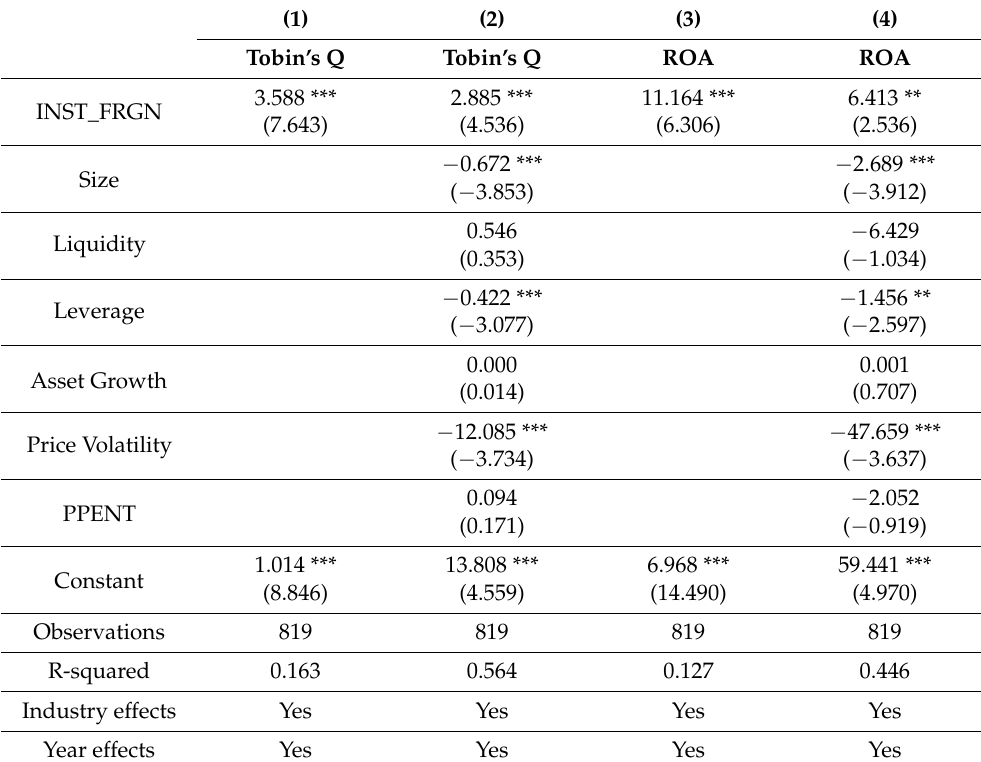
Table 5. Impact of Foreign Ownership on Firm Performance. results of Equation (1) using OLS estimation